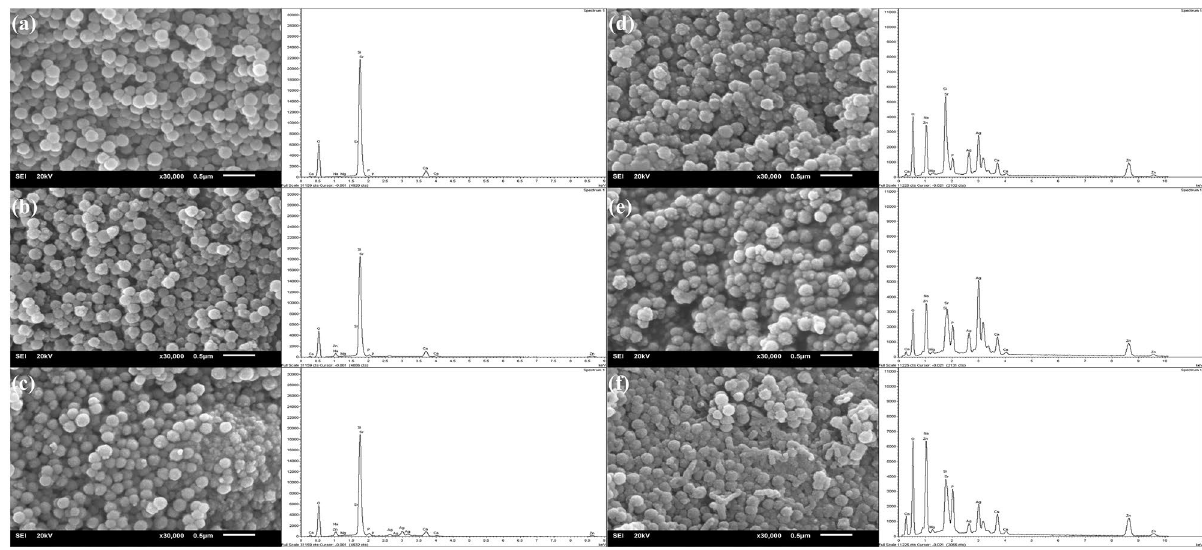
Figure 4. SEM images (Left panel) and EDX-SEM (Right panel) of sol–gel derived BGNPs ( a ) 0Ag–0Zn- BGNPs, ( b ) 0Ag–1Zn-BGNPs, ( c ) 0.5Ag–1Zn-BGNPs, ( d ) 1Ag–1Zn-BGNPs, ( e ) 1.5Ag–1Zn-BGNPs, and ( f ) 1.5Ag–1.5Zn-BGNPs after incubation in the SBF solution for 21 days (operating at 20 kV and magnification 30 kX, scale bars = 500